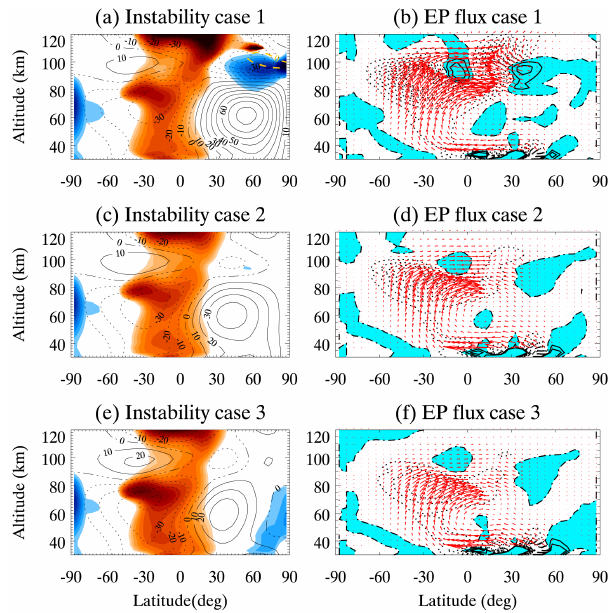
Figure 7. The zonal mean zonal wind during model days 25–30 for (a) case 1, (c) case 2, and (e) case 3. The baroclinic/barotropic instabilities are overplotted with blue shades. The orange shaded region denotes the positive (propagating) waveguide ( m 2 ) for W3. Shown on the right are the EP flux vectors (red arrows) and their divergences (light blue shade for positive value, dot line for negative value) for (b) case 1, (d) case 2, and (f) case 3. The contour intervals for the EP flux divergence are 2ms − 1 day − 1 .